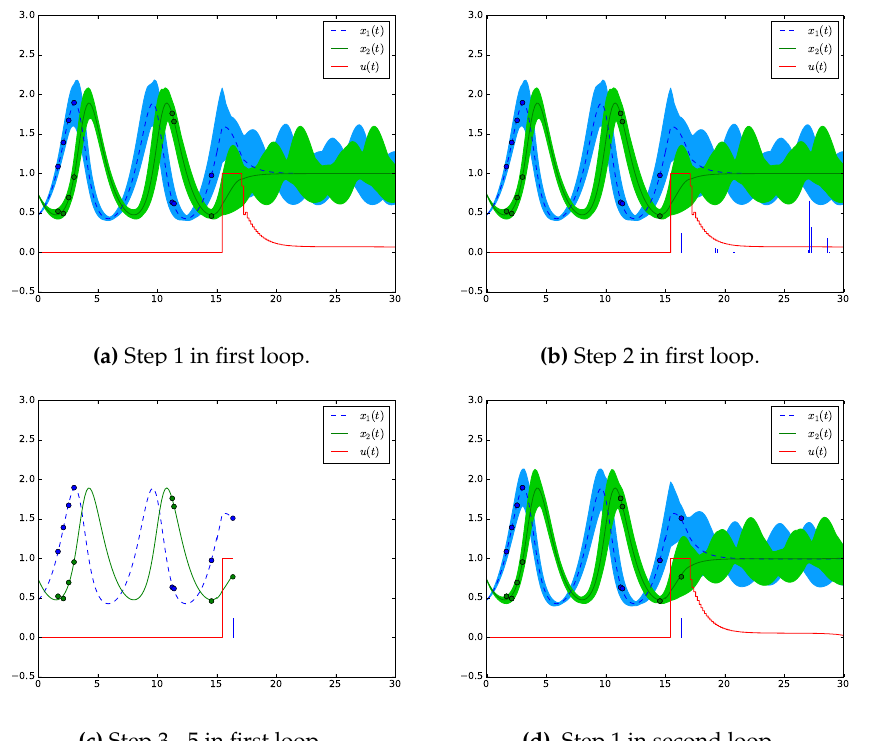
Figure 1. Visualization of Algorithm 2 performing one loop applied to the Lotka-Volterra fishing example. In Figure 1a the first step, solving an optimal control problem, of Algorithm 2 is performed on the time interval [ 15,30 ] with initial values from a parameter and state estimation on the interval [0,15] with measurements from an optimal experimental design problem. The uncertainty tubes are computed from 100 simulations with parameter samples from a normal distribution with the estimated parameters and uncertainties as mean and variance. In Figure 1b an optimal experimental design is computed on t ∈ [ 15,30 ] with the optimal control strategy. The strictly positive optimal sampling weights are visualized as vertical lines. Next, the optimal control strategy is performed until time point t i at which the first sampling weight is strictly positive and a measurement is taken. Afterwards a state and parameter estimation is performed (Figure 1c). The loop starts again with solving a OCP on [ t i ,30] with the estimated values. The new optimal control strategy is shown in Figure 1d with uncertainty tubes computed from 100 simulations with updated mean and